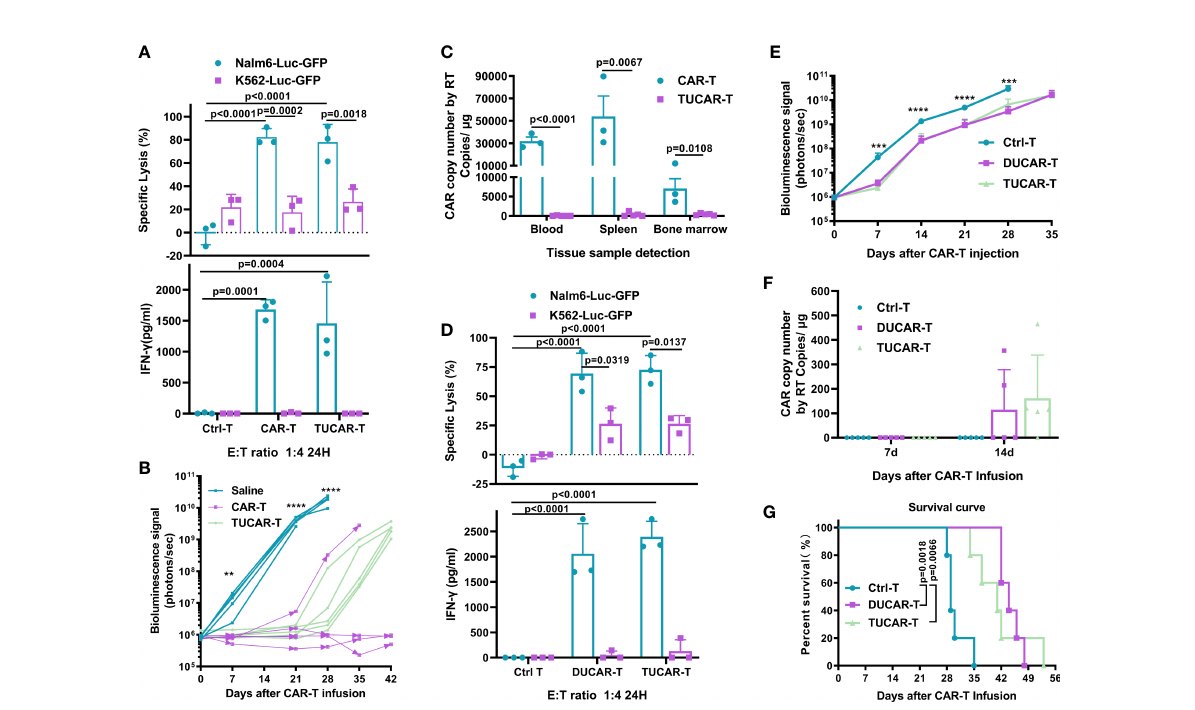
FIGURE 2 TUCAR-T has comparable antitumor ef fi cacy in vivo with unedited CAR-T cells but exhibited less persistency. (A) (Top) Cytotoxicity of CAR-T and TUCAR-T cells was assessed by measuring the percentage of tumor cell lysis using the luciferase assay. (Bottom) IFN- g release was analyzed by ELISA (n=3). (B) BLI of mice receiving different treatments (n=5). (C) Peripheral blood, spleen, and bone marrow from Nalm6- bearing NOG mice treated with different CAR-T cells were obtained on day 42 after CAR-T infusion for the presence of the copies of the CAR transgene by RT-PCR (BBz) (TUCAR-T: n=5, CAR-T: n=3). (D) (Top) Cytotoxicity of DUCAR-T and TUCAR-T cells was assessed by measuring the percentage of tumor cell lysis using the luciferase assay. (Bottom) IFN- g release was analyzed by ELISA (n=3). (E) , BLI from each group of mice (n = 5). (F) , Peripheral blood from Nalm6-bearing NOG mice treated were obtained on day 7 and 14 for the presence of copies of the CAR transgene by and RT-PCR (BBz) after CAR-T cell injection (n = 5). (G) , Survival curve of mice (n=5). All data represent the mean ± SD. Statistical signi fi cance was determined with two-tailed, unpaired Student ’ s t -test (C) and one-way ANOVA with Tukey ’ s correction for multiple comparisons (A, B, D, E, F) , or the log-rank (Mantel – Cox) test (G) . Signi fi cances of p ≤ 0.01 are indicated by 2 asterisks (**), p ≤ 0.001 are indicated by 3 asterisks (***), p ≤ 0.0001 are indicated by 4 asterisks